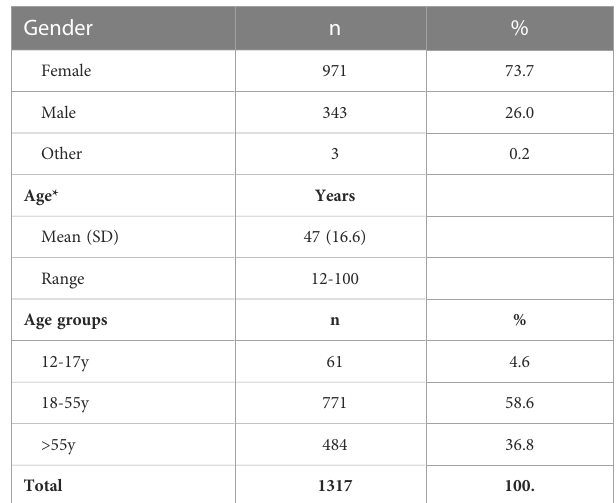
TABLE 1 Demographics of the cohort of patients.